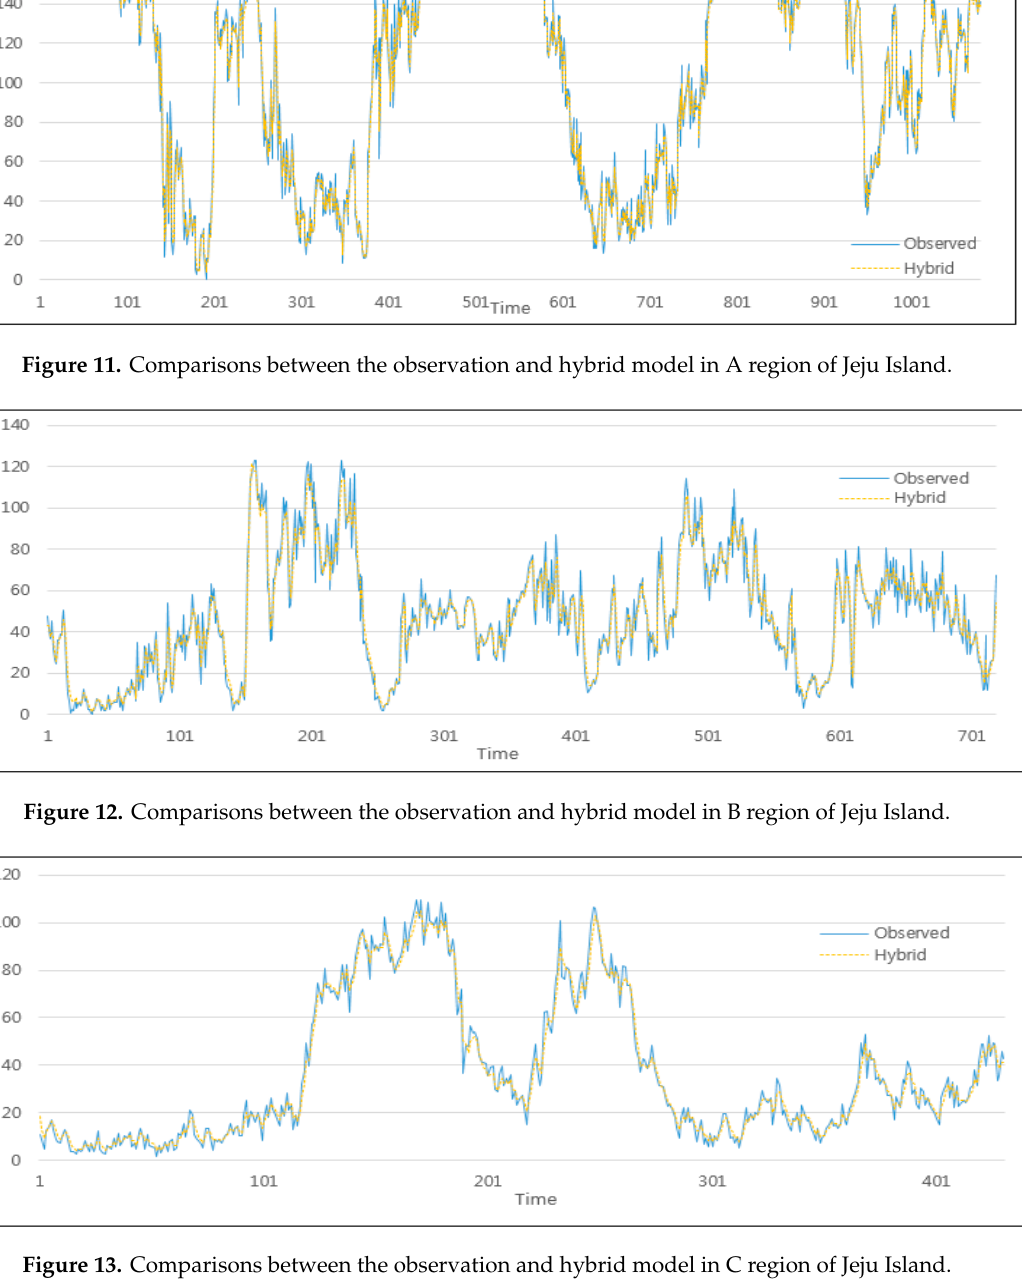
Figure 13. Comparisons between the observation and hybrid model in C region of Jeju Island.